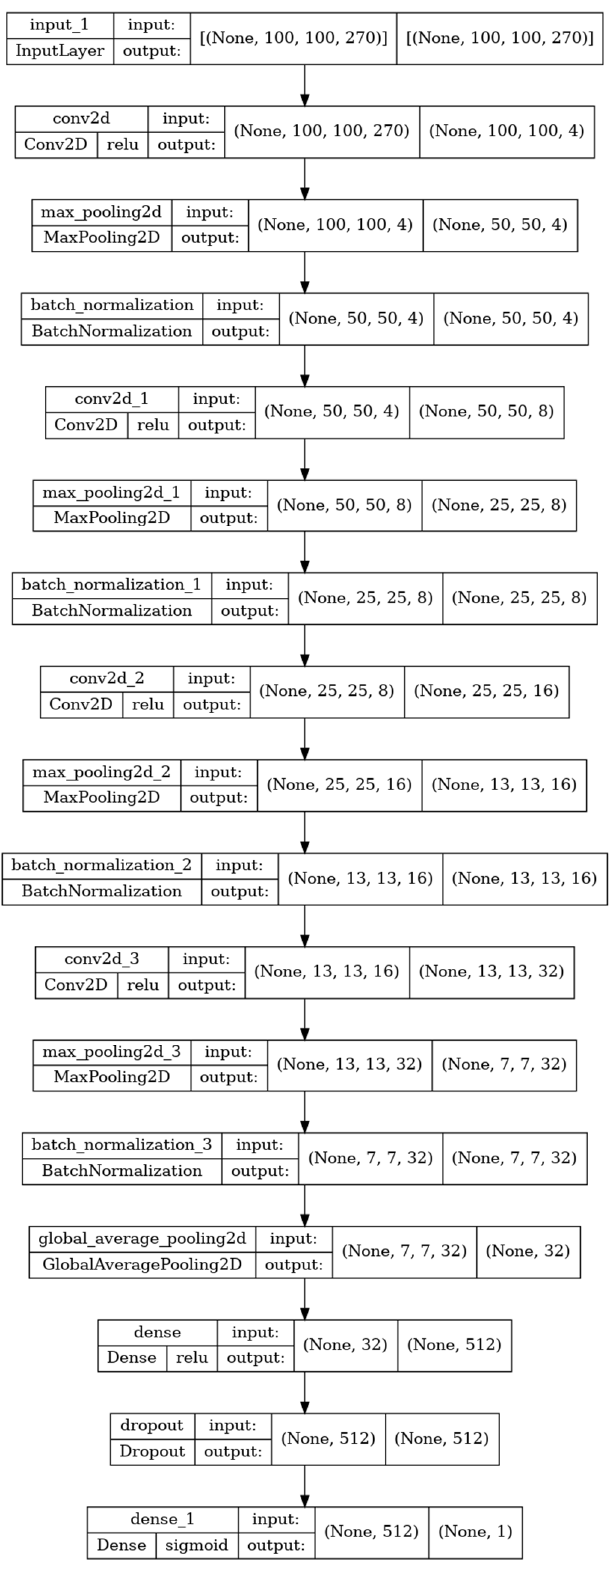
Figure A3. Topology of 2D-CNN utilized for HSI data.